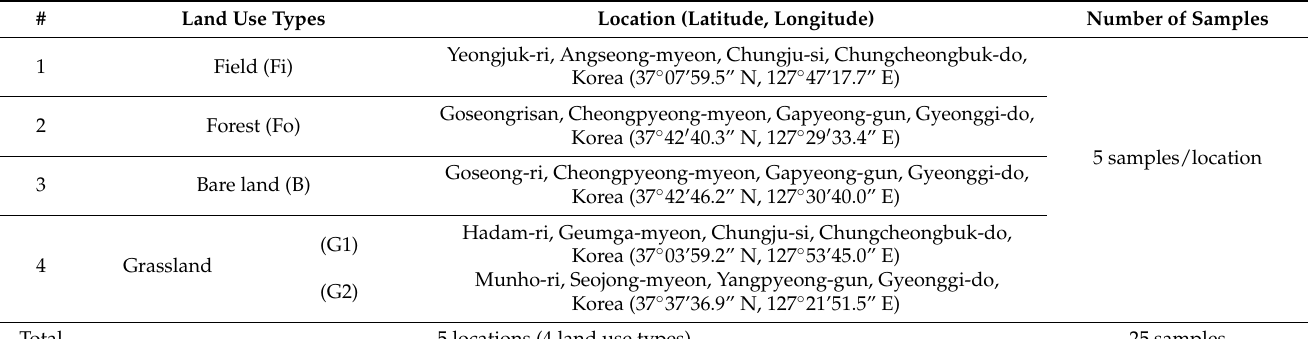
Table 1. Information on sampling locations in South Korea. Five samples were collected per